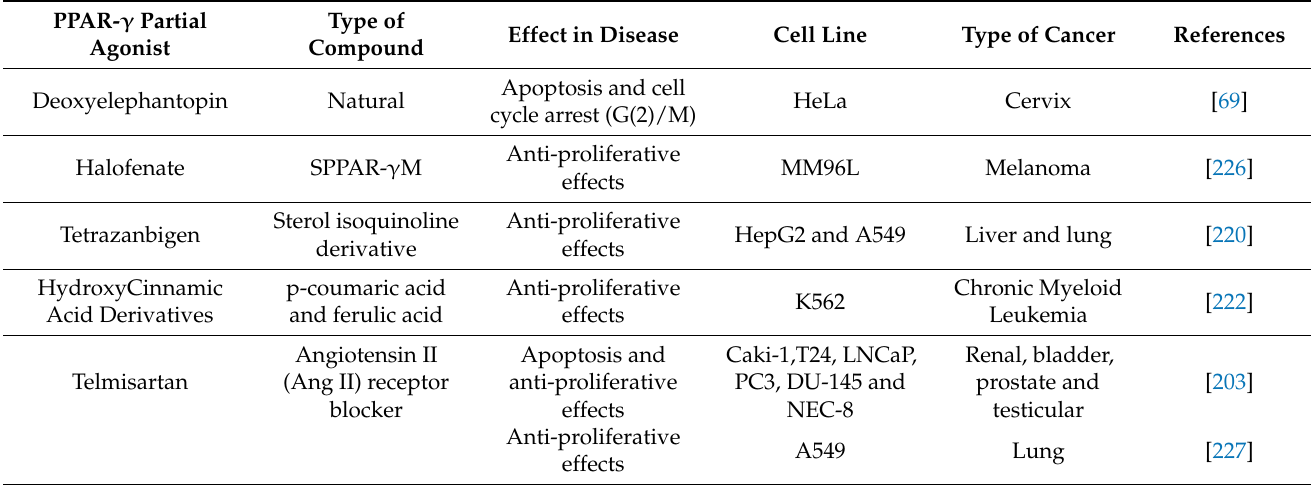
Table 4. List of PPAR- γ partial agonists and their significant role in cancer